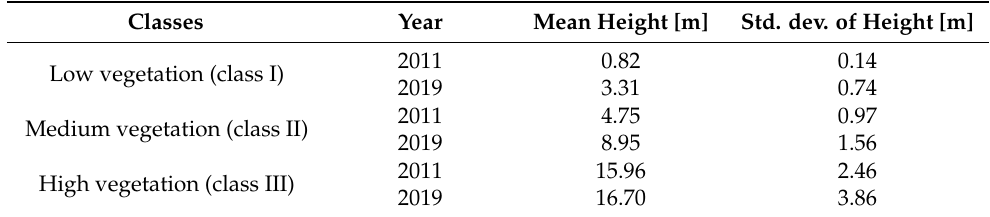
Table 3. ALS metrics for the class of vegetation—mean values of height and std. dev. of height.